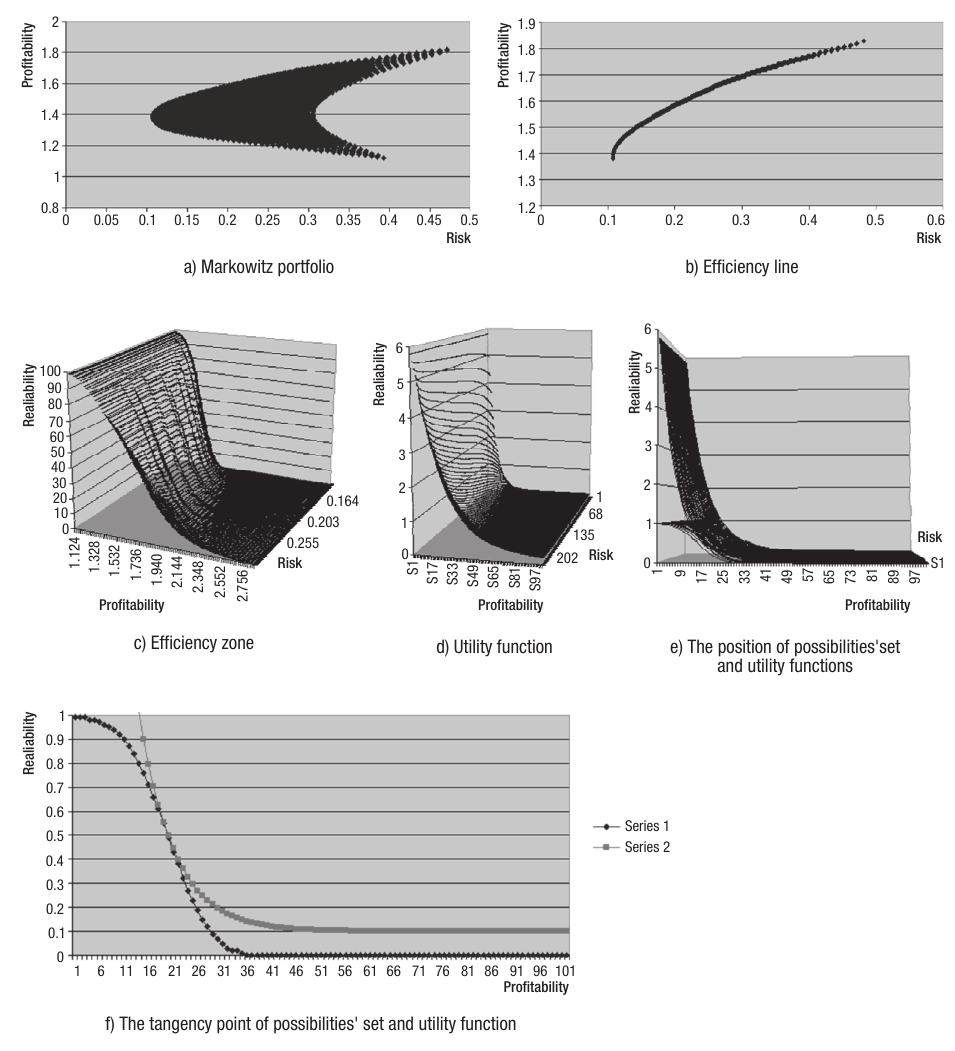
Fig. 4. Visualization of (1)–(3) problem